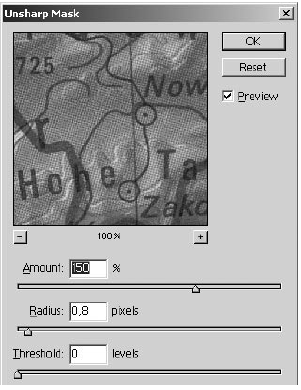
Fig 4. Properties of filter Unsharp Mask